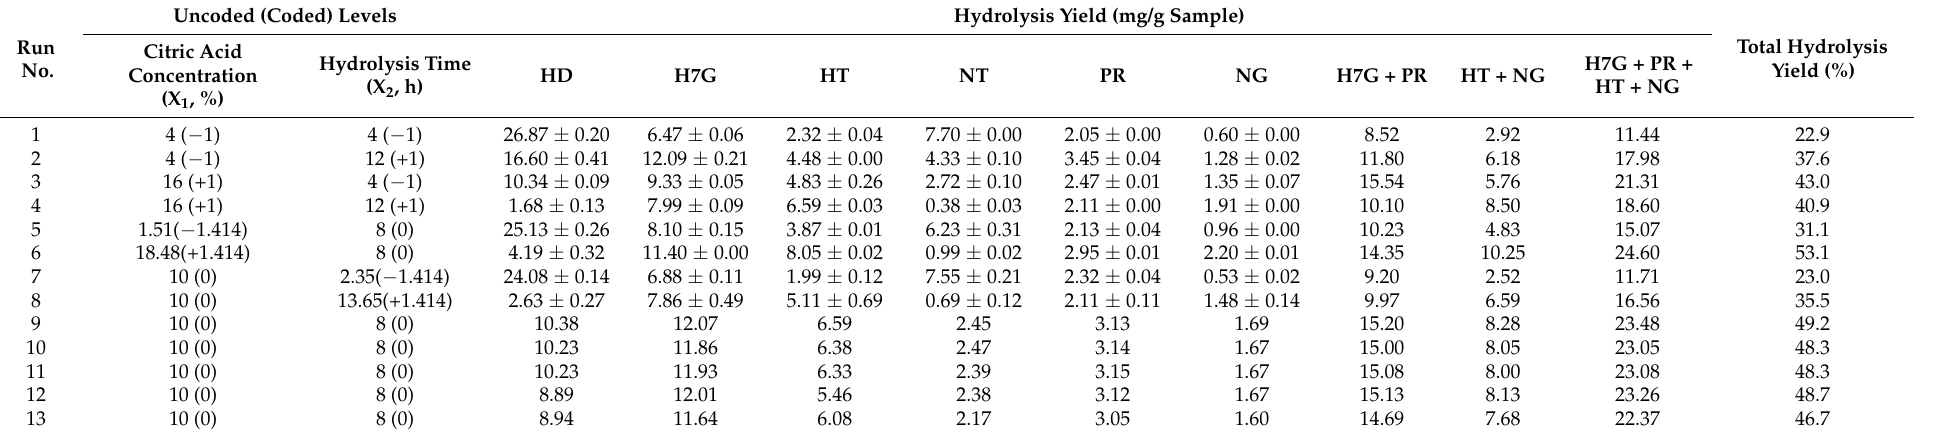
Table 1. Central composite design and corresponding flavonoid yields in subcritical water hydrolysates from immature Citrus unshiu pomace.